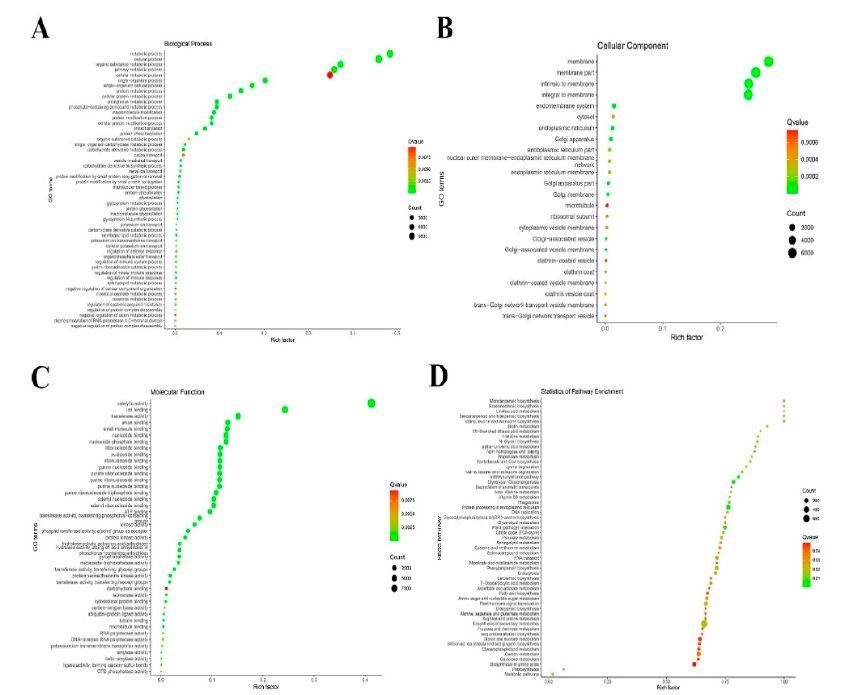
Figure 4. GO and KEGG pathway enrichment analysis of differentially expressed lncRNAs (DElncRNAs) in response to Chinese wheat mosaic virus in Nicotiana benthamiana . To analyze DElncRNAs function, we predicted potential target genes of these DElncRNAs and evaluated them by GO and KEGG pathway analysis. These potential target genes were individually enriched into biological processes ( A ), cellular components ( B ), molecular function ( C ), and KEGG pathway ( D ). The Rich factor is the ratio of differentially expressed gene numbers annotated in this pathway term to all gene numbers annotated in this pathway term. The Q-value is a corrected p -value ranging from 0 to 1, with lower values indicating greater intensiveness. The circle represented the number of enriched genes, with a larger number indicating more enriched genes.